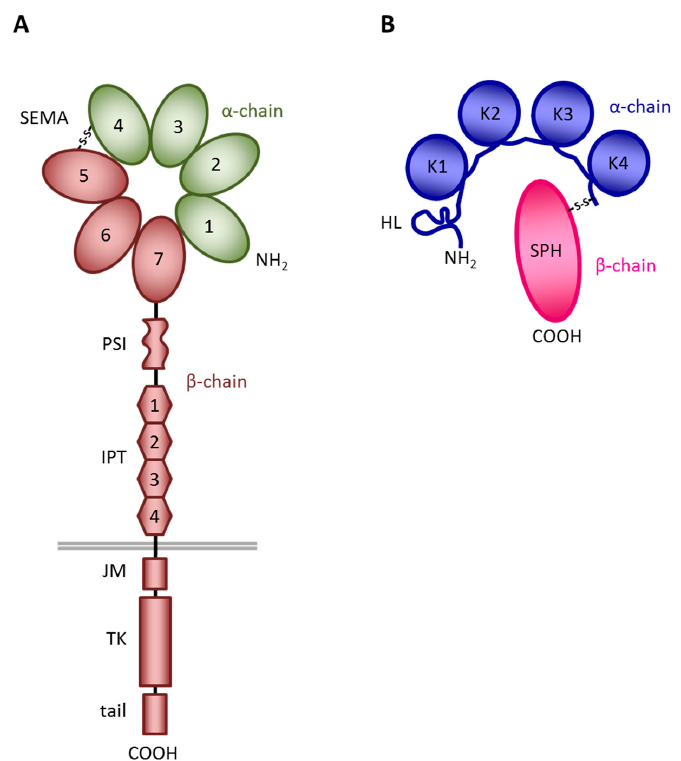
Figure 1. Schematic structure of MET and HGF. ( A ) MET structure. SEMA, a seven-bladed β -propeller domain shared with Semaphorins and Plexins; PSI, a cysteine-rich domain present also in Plexins, Semaphorins, and Integrins; IPT, four immunoglobulin-like domains present also in Plexins and Transcription factors; JM, juxtamembrane domain, a region containing residues that act as negative regulators of the kinase activity; TK, tyrosine kinase domain endowed with enzymatic activity; tail, a C-terminal domain containing the multifunctional docking site. In green the α -chain, in brown the β -chain of MET. The grey line represents the cell membrane. ( B ) HGF structure. HL, hairpin loop; K1–K4, kringle domains; SPH, serine-protease homology domain, devoid of protease activity. In blue the α -chain, in red the β -chain of HGF. S-S, disulphide bond linking the α - and β -chains of the two